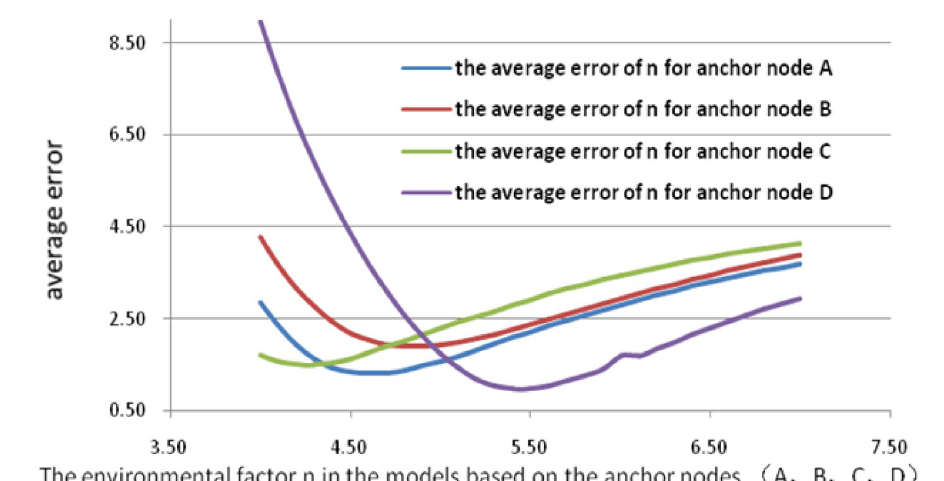
Figure 7. The formulation-relationship between n and